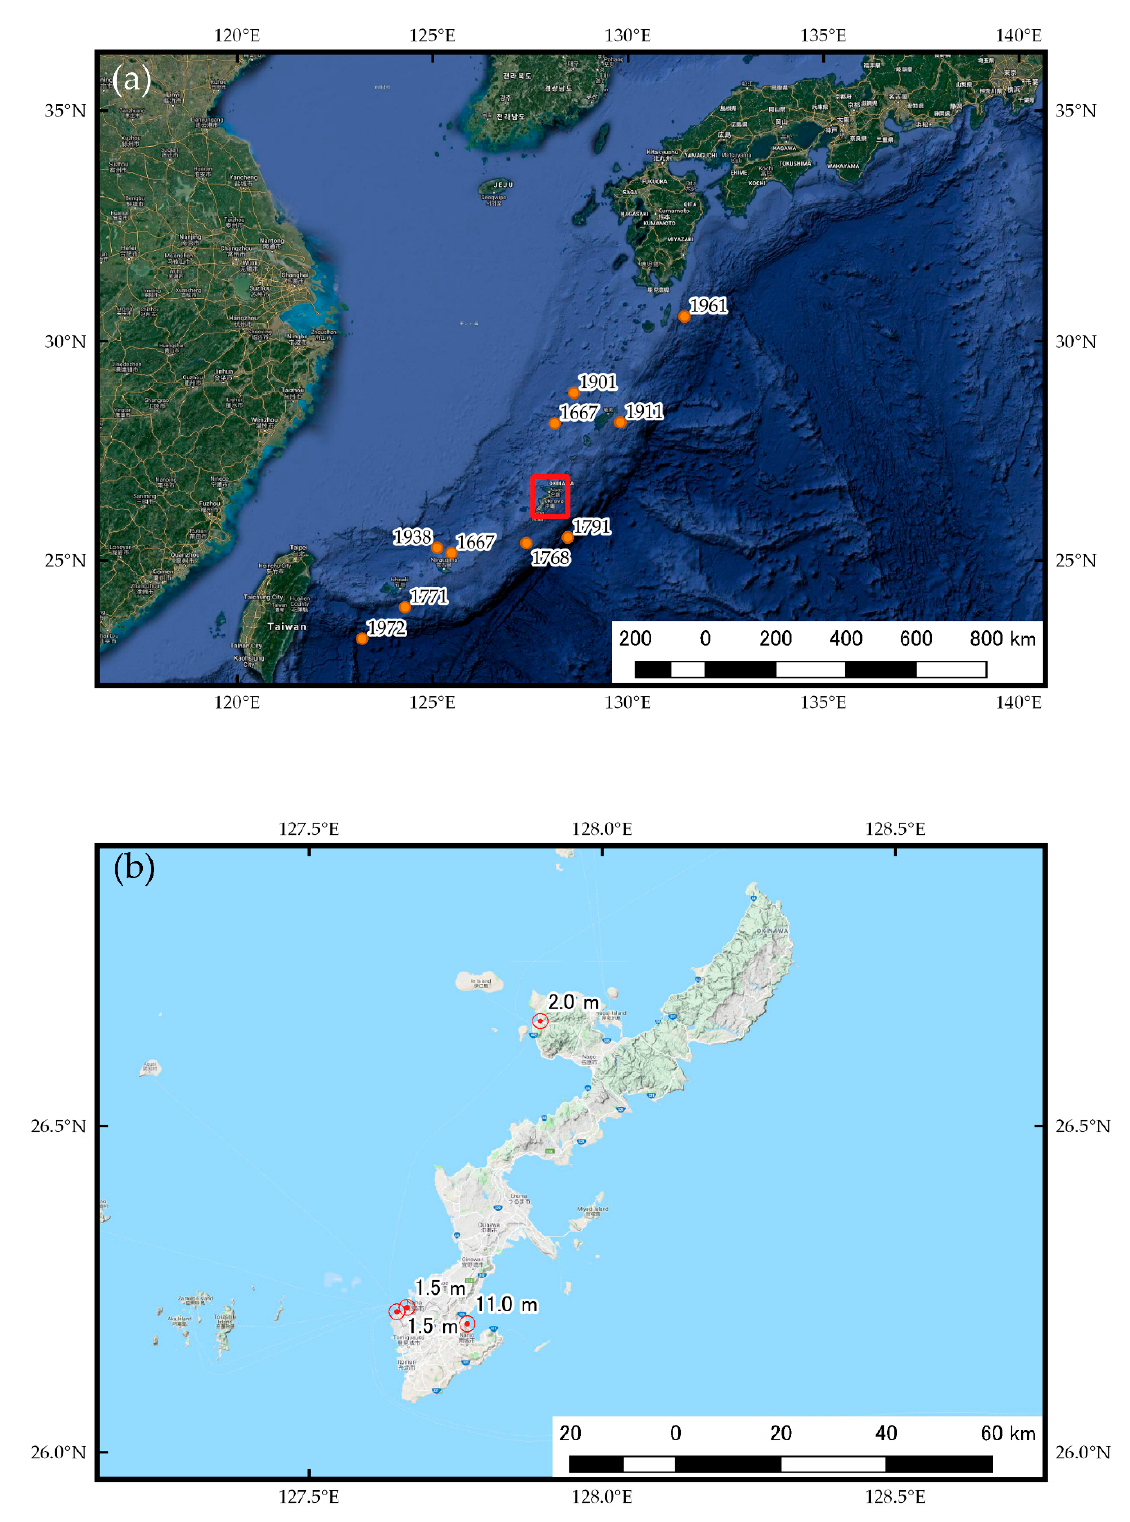
Figure 1. Location of Okinawa Island, ( a ) Study area in the red box and historical earthquakes around Okinawa Island, ( b ) The observation data on the historical event (1791).